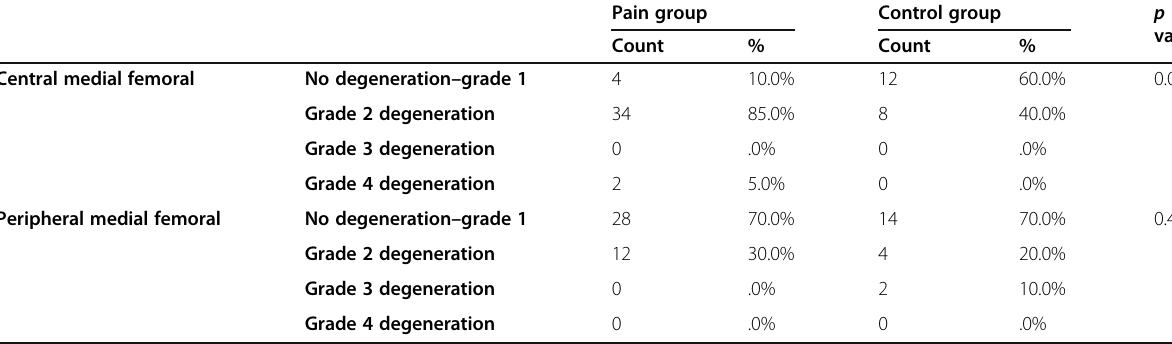
Table 4 Distribution of central and peripheral medial femoral degeneration according to ICRS degeneration